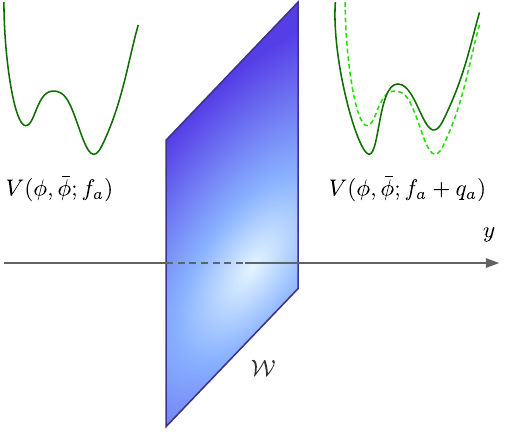
Figure 1 . A membrane inducing a jump on the fluxes, thus modifying the potential in the different regions separated by the